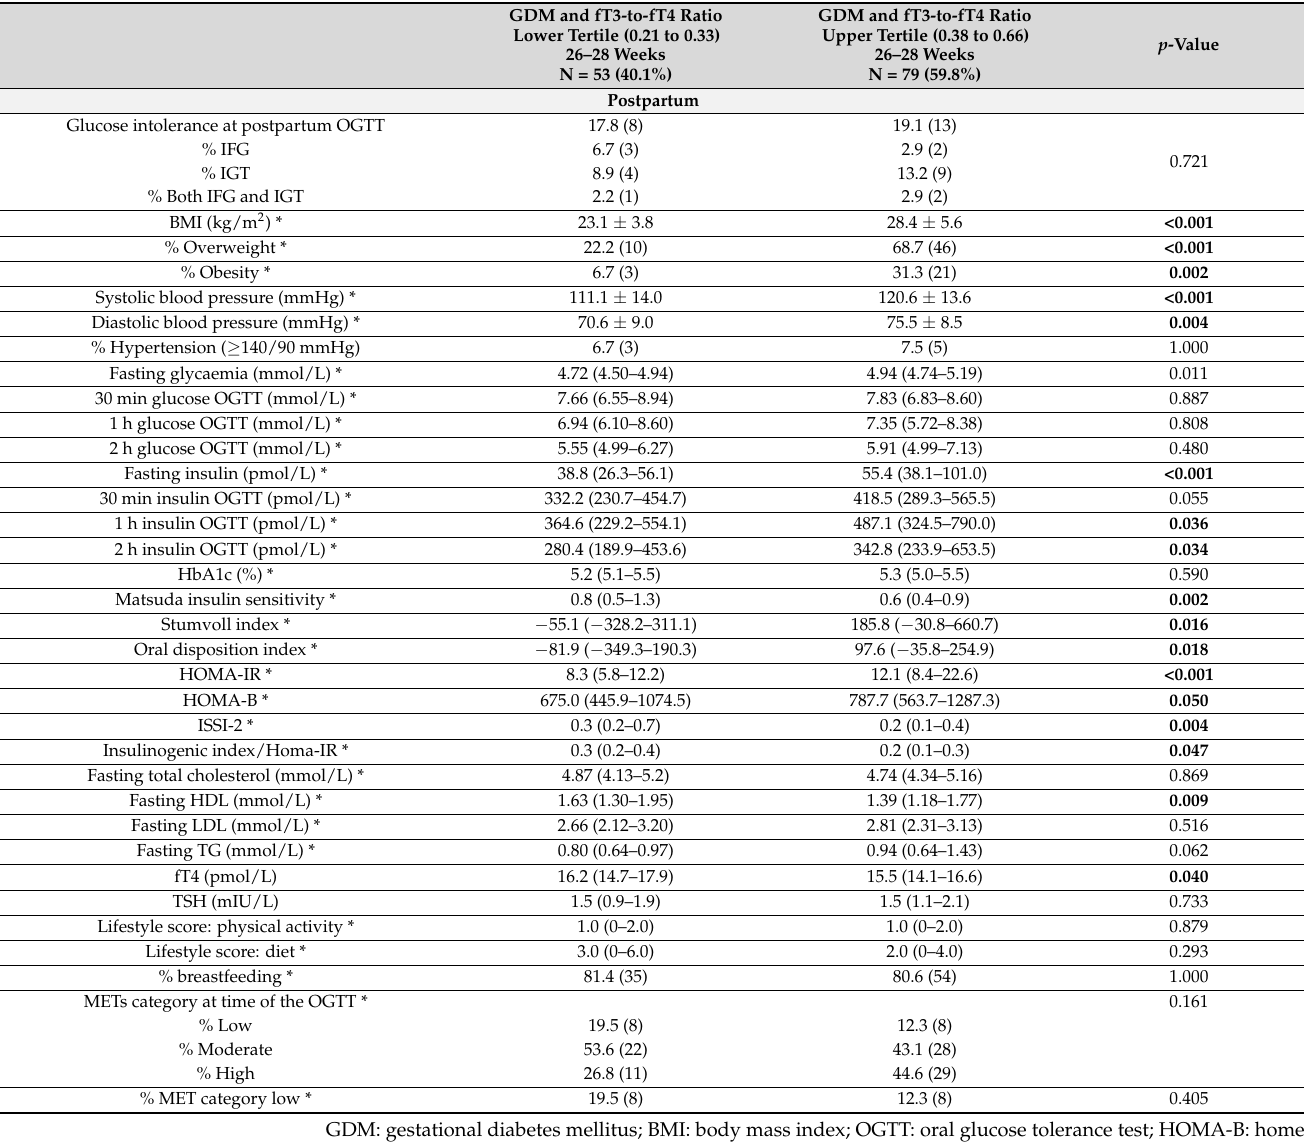
Table A3. Postpartum characteristics in GDM according to lower and upper tertiles of the fT3-to-fT4 ratio. GDM and fT3-to-fT4 Ratio Lower Tertile (0.21 to